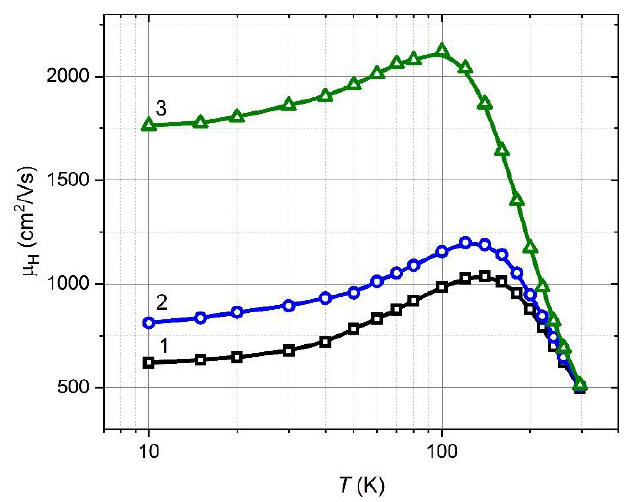
Figure 6. Measured temperature dependence of the Hall mobility µ H of Pb 0.99 In 0.01 Te for various film thickness. Numbers correspond to different film thickness grown T s = 598 K: 1 — 2 µm, 2 — 3 µm, 3 — 4 µm.